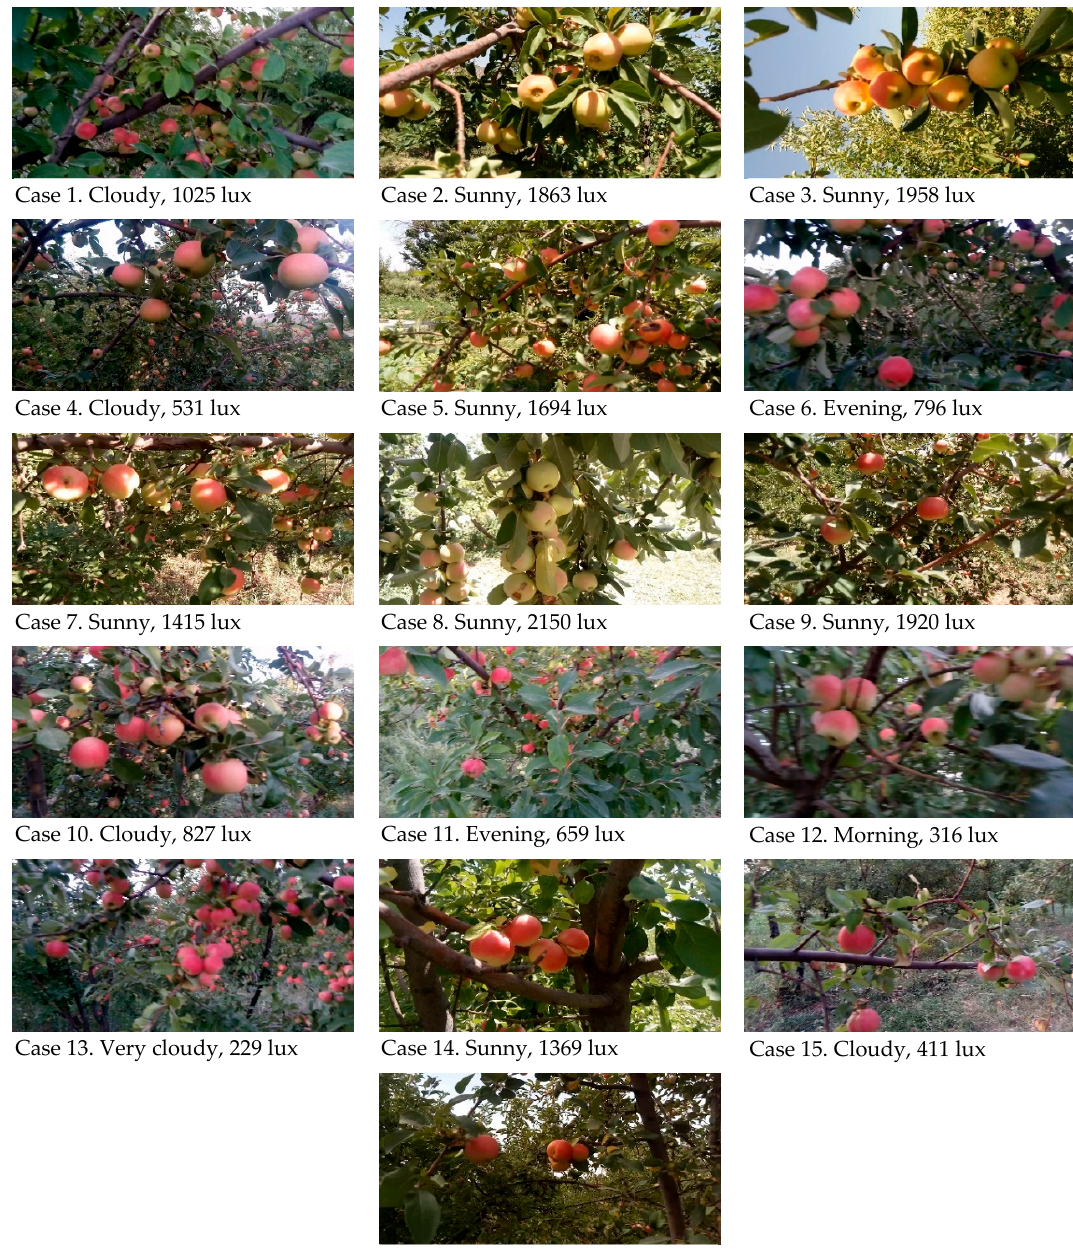
Figure 2. Sample frames of videos taken under different lighting conditions. For each case, the weather condition and the measured light intensity (in lux) is indicated.